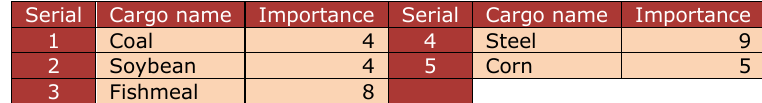
Table 8. Importance of cargo